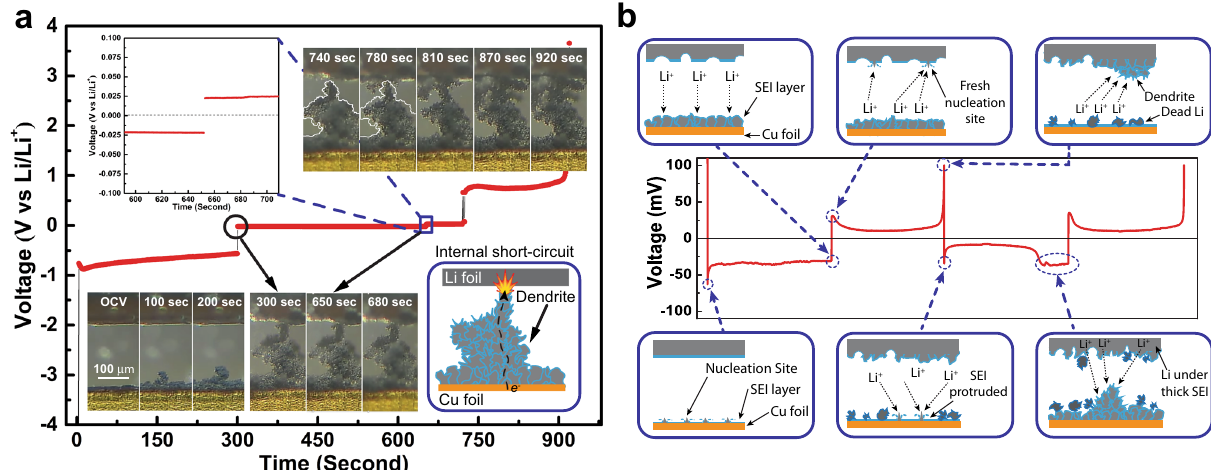
Fig. 1 In situ OM and Li deposition/dissolution scheme. a In situ OM measurement of Li deposition/dissolution on Cu electrode under an ultrahigh current density of 500 mAcm − 2 for demonstration of short-circuiting. It should be noted that the observed short circuit region is different from the initial observation region for Li-plating process. b Scheme of Li deposition/dissolution on Cu foil during cycling of Li/Cu cell under a current density of 0.2mAcm − 2